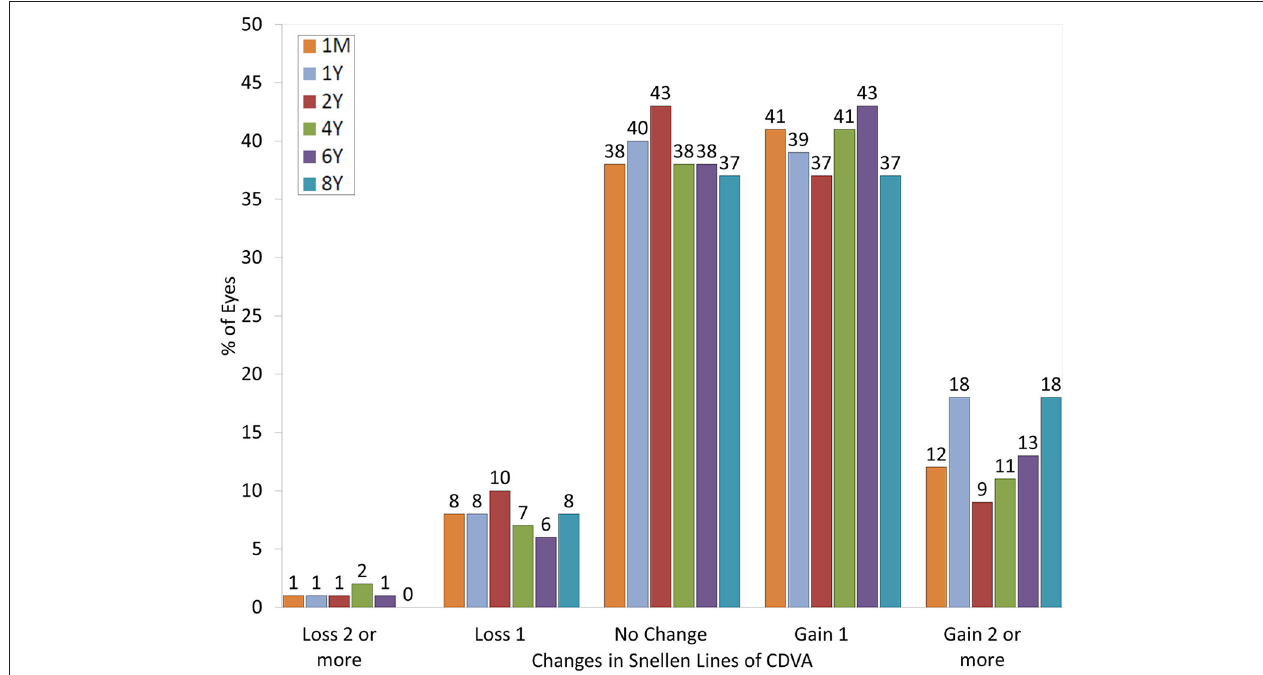
FIGURE 1 | Changes in corrected distance visual acuity (CDVA) after hole implantable collamer lens (EVO-ICL) implantation.